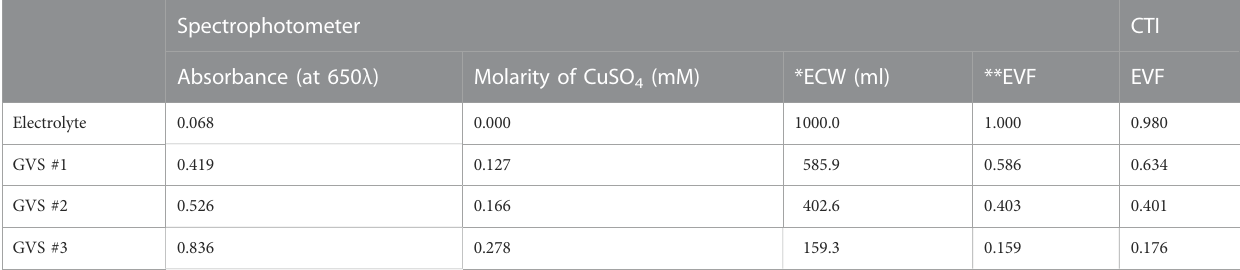
p Indicates the volume of extracellular water, pp is extracellular volume